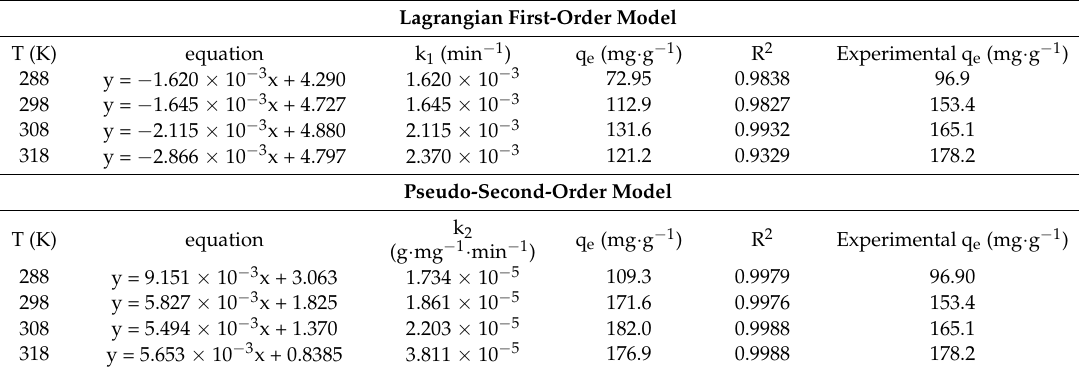
Table 4. Kinetic constants for EBT adsorption by F-SAC.